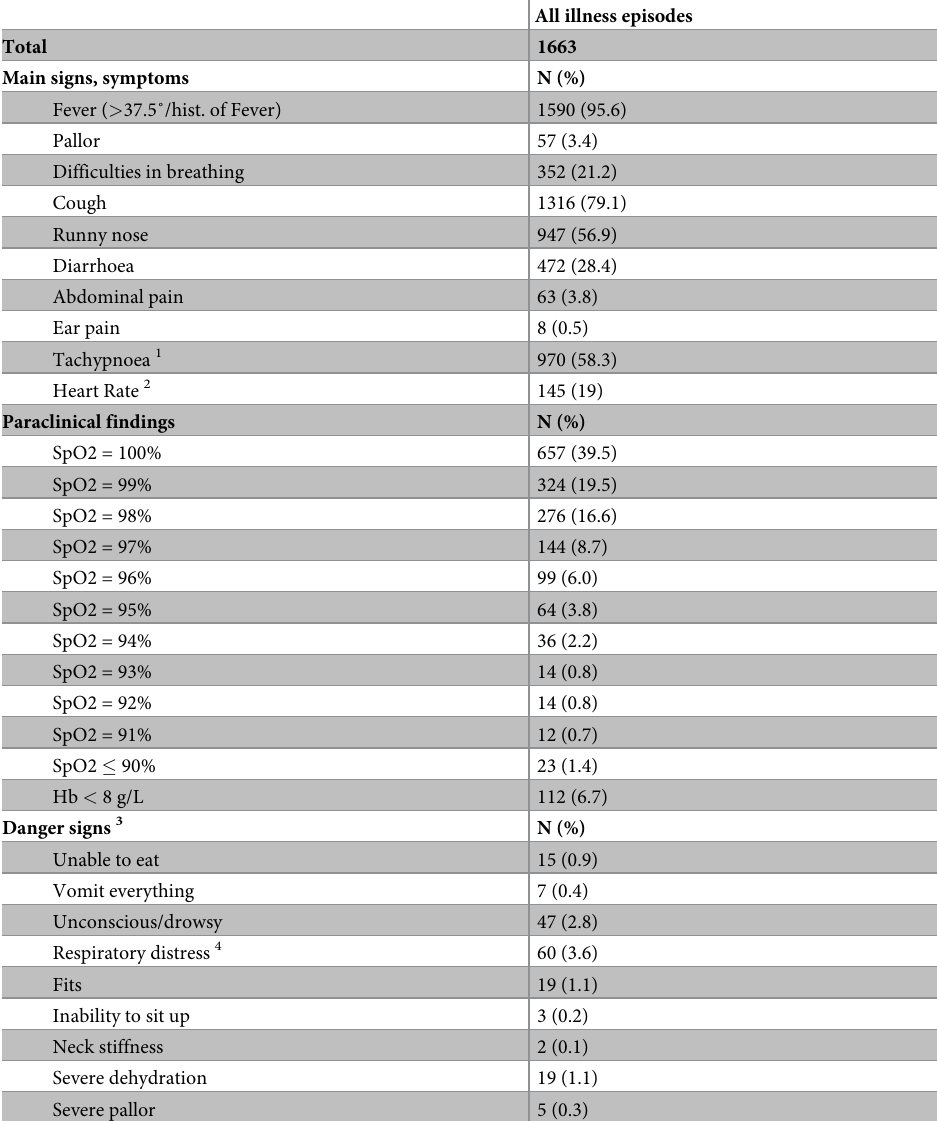
Table 2. General description of the